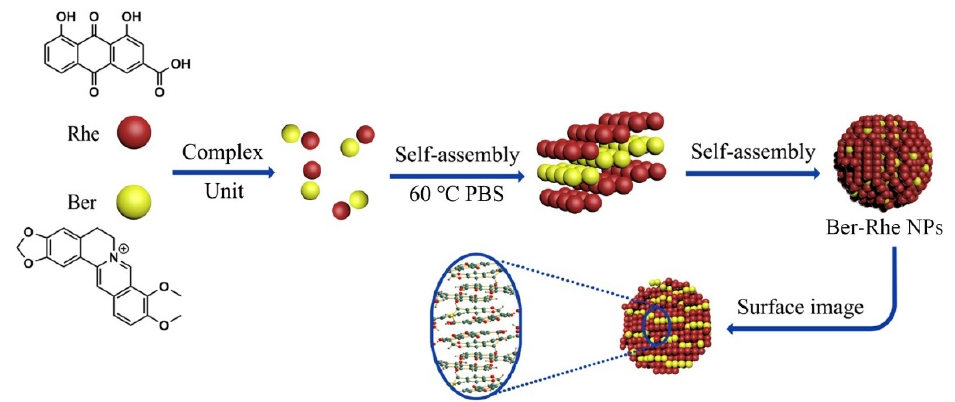
Figure 3. Schematic representation of the self-assembly mechanism of the berberine–rhein (Ber–Rhe) supramolecules [17] . Table 1. Supramolecules in traditional Chinese medicine decoction and their characteristic.